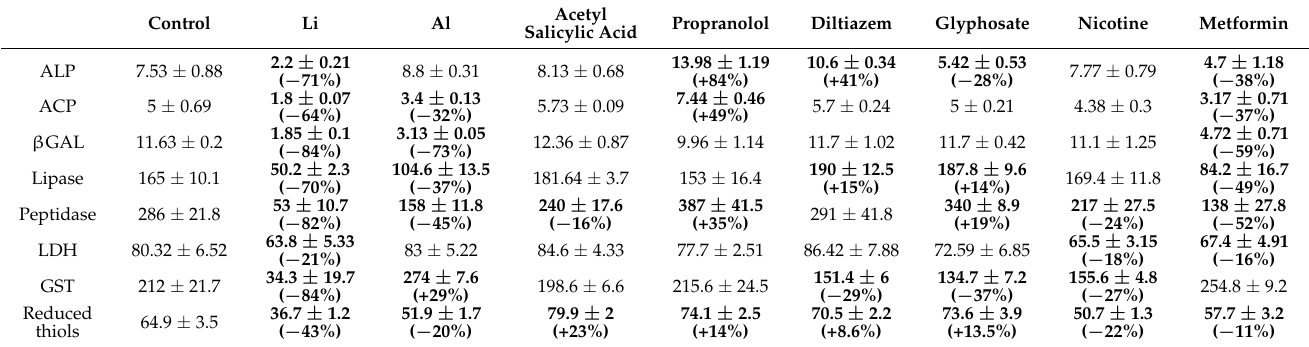
Table 2. Biochemical markers of daphnid physiology upon exposure to a mixture of eight chemicals. Data represent mean ± standard deviation (N = 4) of enzyme activity. Enzyme activity was expressed as units/mg protein for lactate dehydrogenase (LDH), lipase, β -galactosidase and phosphatases, as munits/mg protein for GST, and for reduced thiols in nmoles/mg protein. Bold font indicates statistically significant difference by Student’s t -test compared with the unexposed control.